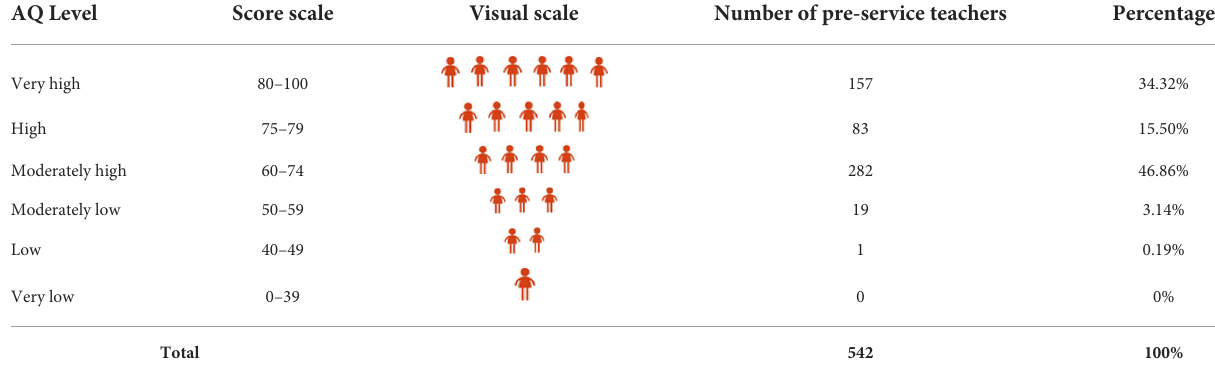
TABLE 8 AQ levels of practicum pre-service